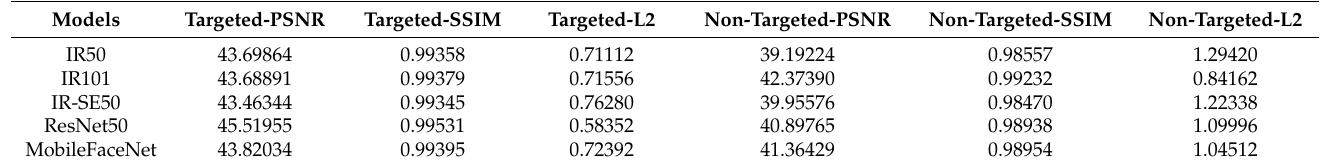
Table 3. Average PSNR, SSIN, and the perturbed parameters for different